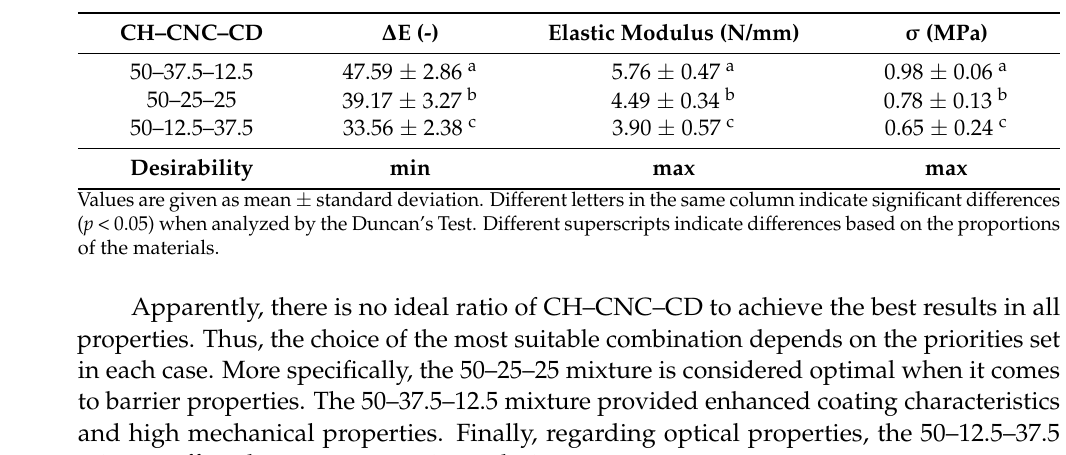
Table 6. Properties of CH–CNC–CD final formed edible